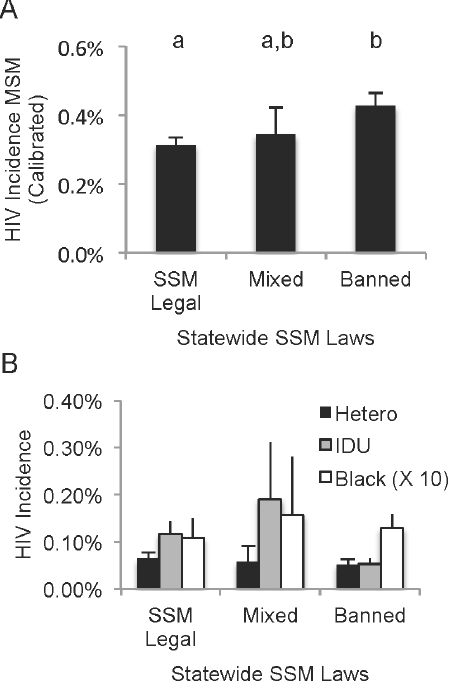
Figure 5. Stigmatization of homosexual behavior (as measured by statewide laws on same sex marriage (SSM)) correlates with increased MSM HIV incidence. Cities were assigned stigma categories based on their state’s position on SSM as of July, 2013. States with legal marriage include 22 cities. States with civil unions, enumerated privilege (with or without constitutional SSM bans) or no relevant laws classified as ‘‘mixed’’ (n=9 cities). States with legislative or constitutional SSM bans (n=48 cities) were classified as ‘‘banned.’’ A. MSM HIV incidence rates represent total HIV reports by single MSM exposure divided by the estimated total GLB individuals per city (from Gates, 2006). Lowercase letters indicate statistically similar populations (by T-test, p . 0.05). B. No pattern or significant difference was found in any other group (shown: HIV incidence by heterosexual or IDU exposure, and black individuals).